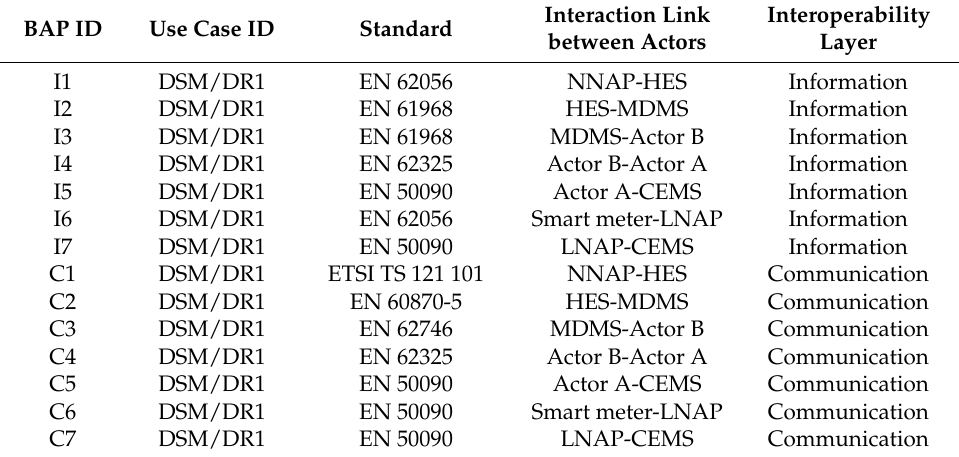
Table 7. BAPs for the equipment comprising the test